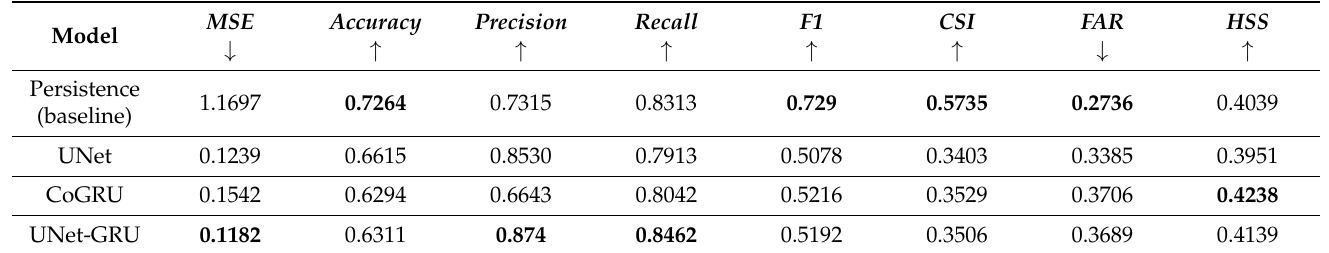
Table 3. MSE and scores on rainfall bigger than 0.5 mm/h indicating rain or no rain. Best result for that score is in bold. A ↑ indicates that higher values for that score are good whereas a ↓ indicates that lower scores are better.